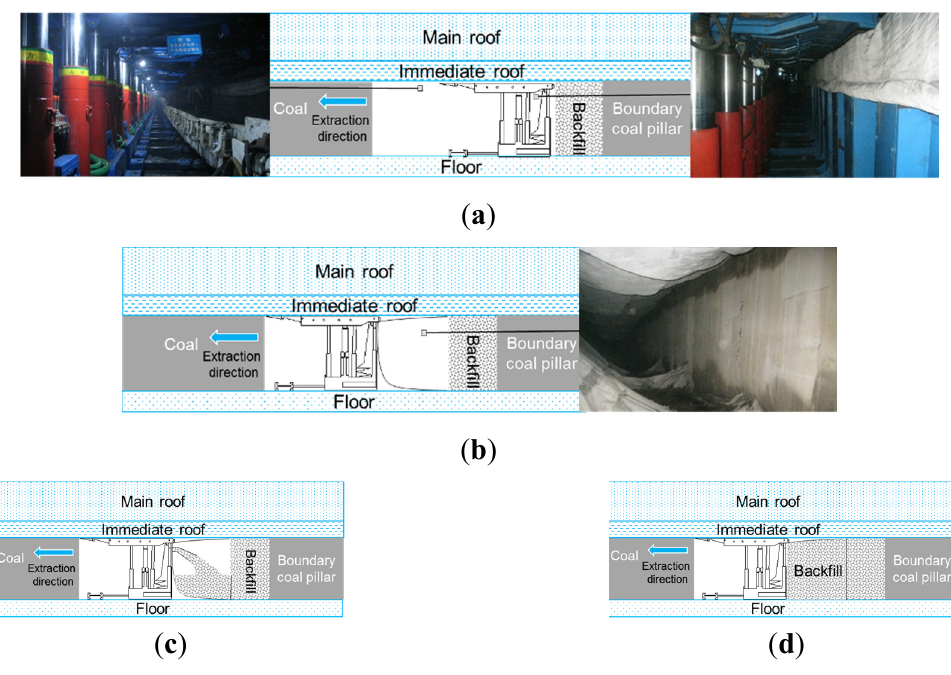
Figure 6. Backfilling procedure for fully mechanised coal mining with self-backfilling hydraulic supports. ( a ) The moment when the first-round backfilling neighbouring the boundary coal pillar is finished; the left and right photos, taken in the Yulin colliery of Shanxi Province, indicate corresponding sections in the centre sketch; ( b ) The left sketch shows the moment when the mould bag stretches as a result of the forward movement of the hydraulic support, which is also indicated in the right photo, also taken in the Yulin colliery of Shanxi Province; ( c ) Backfilling material being pumped into the rear space formed by the mould bag; ( d ) End of the first-round backfilling procedure. (drawings in this figure were designed by Xiaowei Feng and photos were taken by Xigui Zheng and Fei Xue in a related field trial in Shanxi